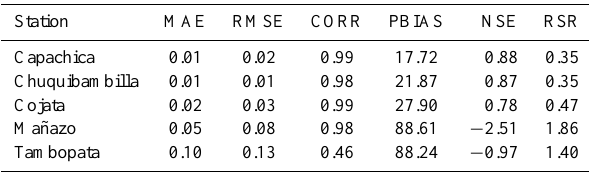
Table 8. Goodness of fit for exceedance probability curves on the dry season (April–October) from 1999 to